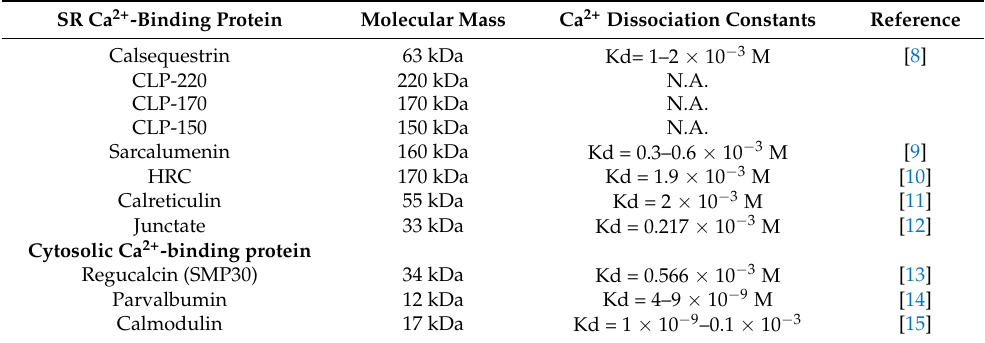
Table 1. Summary of Ca 2+ - binding proteins residing in the cytoplasm or in the lumen of sarcoplas- mic reticulum of skeletal muscle and their molecular mass and Ca 2+ -dissociation constant. SMP, senescence marker protein; CLP, calsequestrin-like protein; HRC, histidine-rich calcium-binding protein; N.A., not